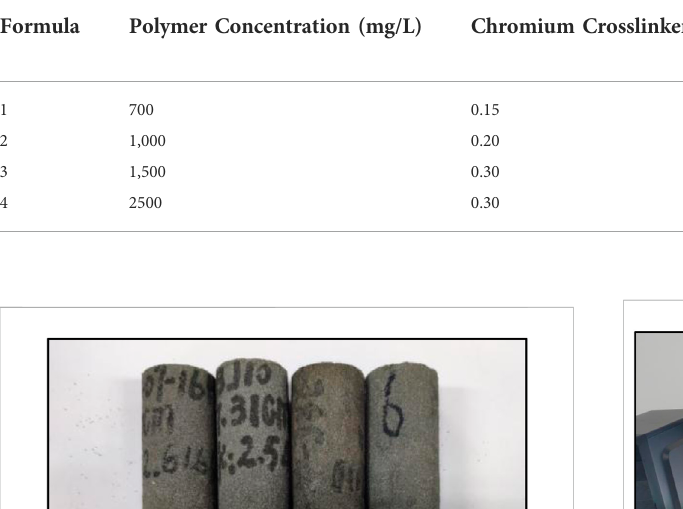
TABLE 2 Composition of polymer gel pro fi le control agent.